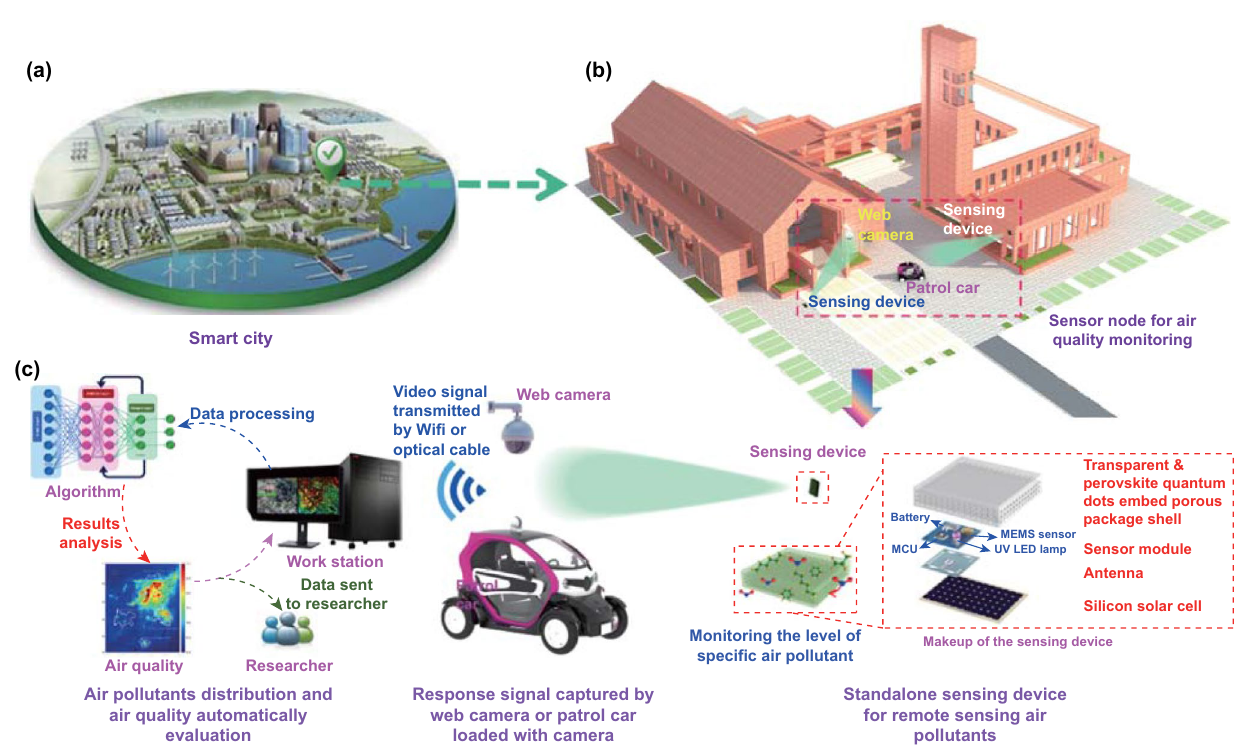
Fig. 1 Illustration of the overall experimental strategy: a, b WSNs deployed city for remote tracking air quality. The standalone-like smart sens- ing device serves as the sensor node for real-time detecting the level of air pollutants; c. Smart sensing device with compact configuration in which all functional units were integrated in a 4 × 4 × 2 cm 3 transparent box is designed in this research. With the assistance of photolumines- cence-enhanced Li-Fi telecommunicating technology, informative signal can be remotely captured by web camera or the camera loaded patrol car. Followed by signal back end processing, the air quality in specific location of the city would be remotely